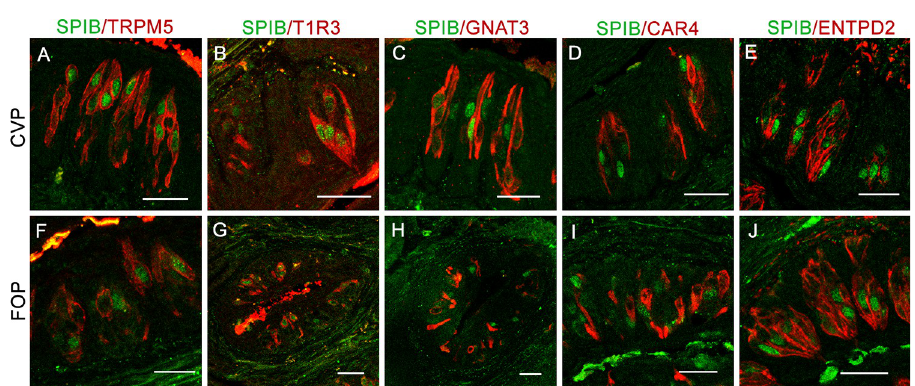
Fig 2. SPIB is coexpressed with T1R3. Double-labeled immunofluorescence confocal microscopy of CVP and FOP sections with antibodies against SPIB and type II taste cell markers TRPM5 ( A , F ), T1R3 ( B , G ), and GNAT3 ( C , H ), the type III taste receptor marker CAR4 ( D , I ), and the type I taste cell marker ENTPD2 ( E , J ) show frequent coexpression of SPIB with T1R3 and less frequently with TRPM5 and GNAT3 and negligible coexpression with CAR4 and ENTPD2. Nuclei are counterstained blue with DAPI. Scale bar, 50 μ m.